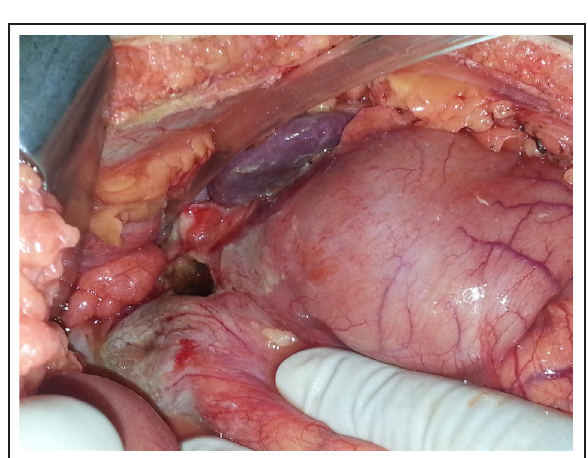
Figure 3. Plain radiograph of chest erect view showing gas under right dome of diaphragm.